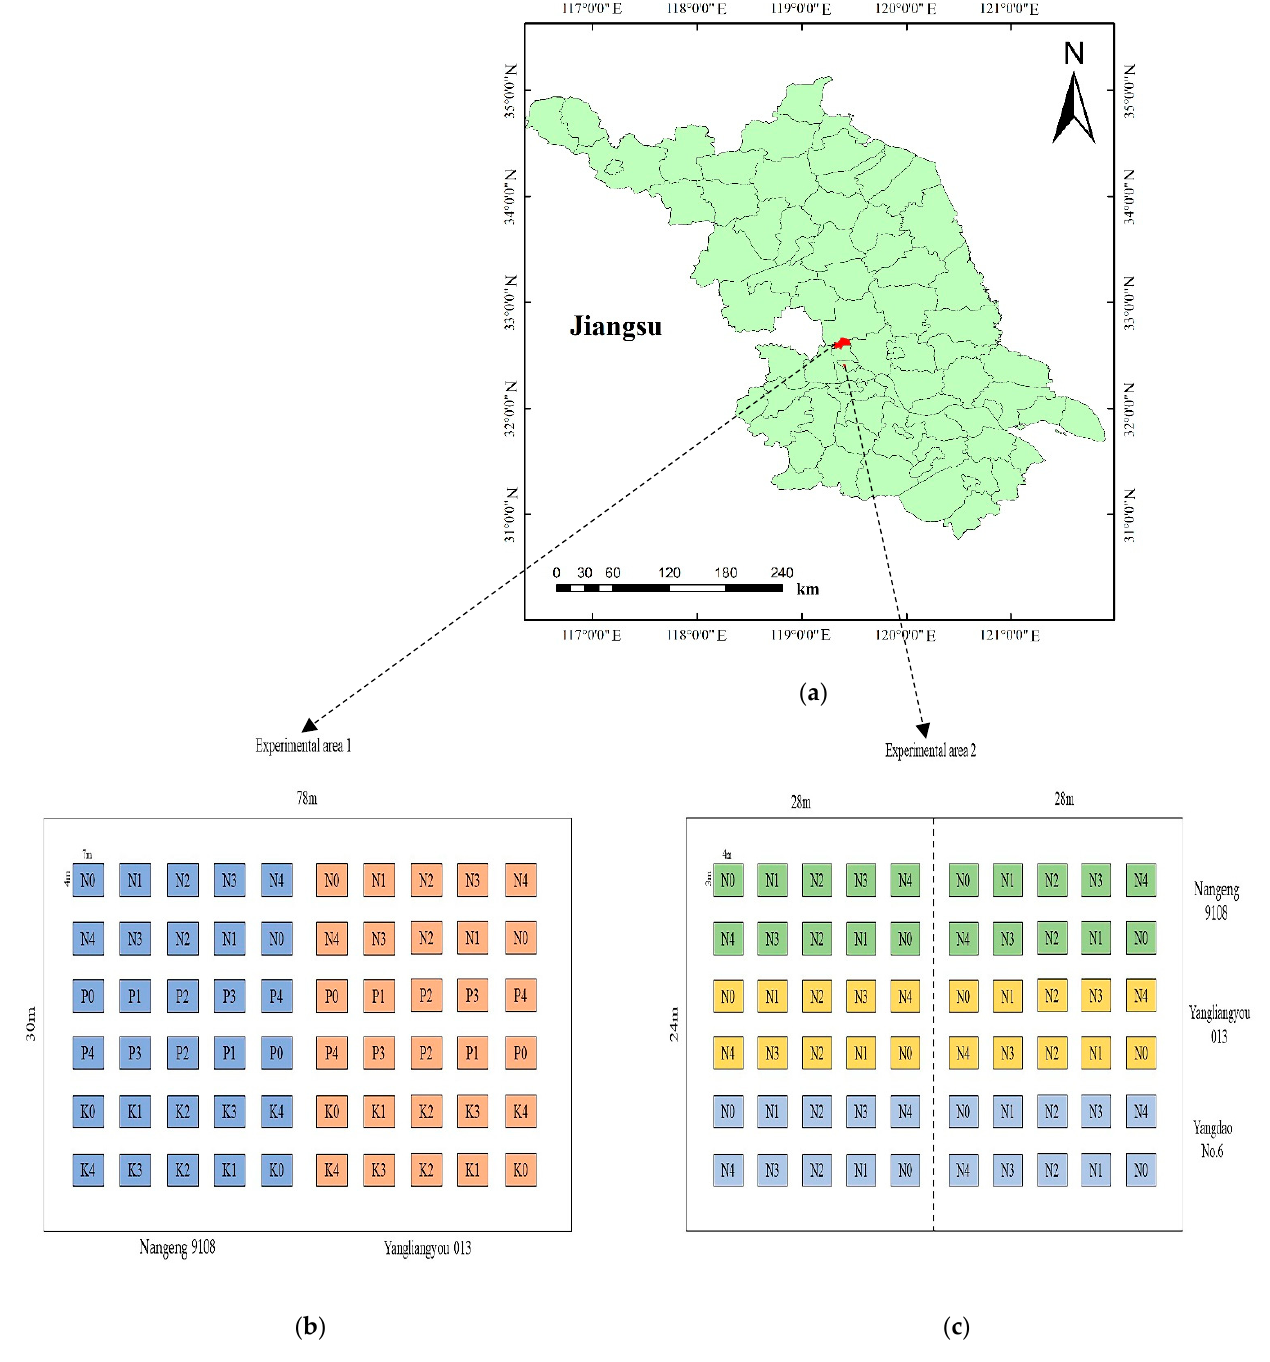
Figure 2. Study area overview. ( a ) Study area location; ( b ) experimental area 1 and plot distribution; ( c ) experimental area 2 and plot distribution.